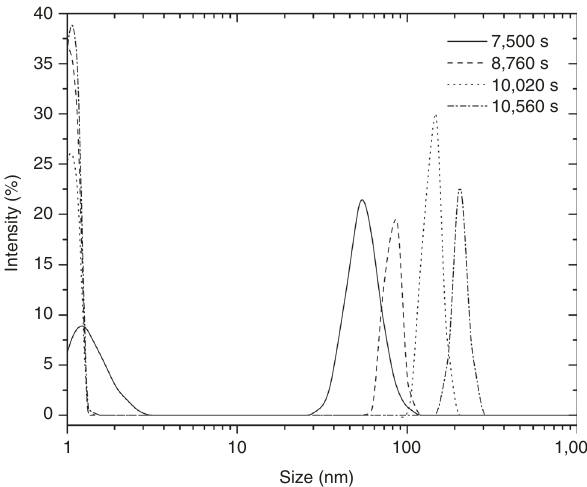
Fig. 6 In situ analysis of particle size distribution of calcium oxalate precipitates. Evolution of particle size distribution in titration experiments performed in the presence of 10 mM citrate, obtained by in situ dynamic light scattering (DLS)